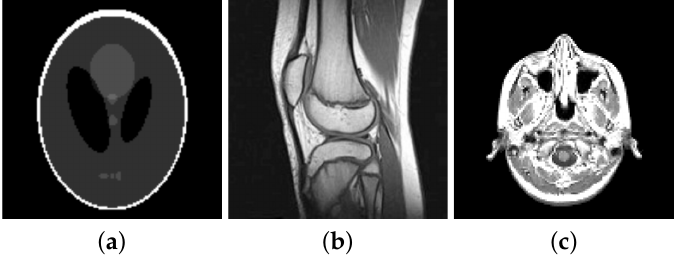
Figure 2. Original images ( a ) Shepp-Logan phantom of size 128 × 128 pixels ( b ) knee of size 200 × 200 pixels ( c ) slice of a human brain of size 128 × 128